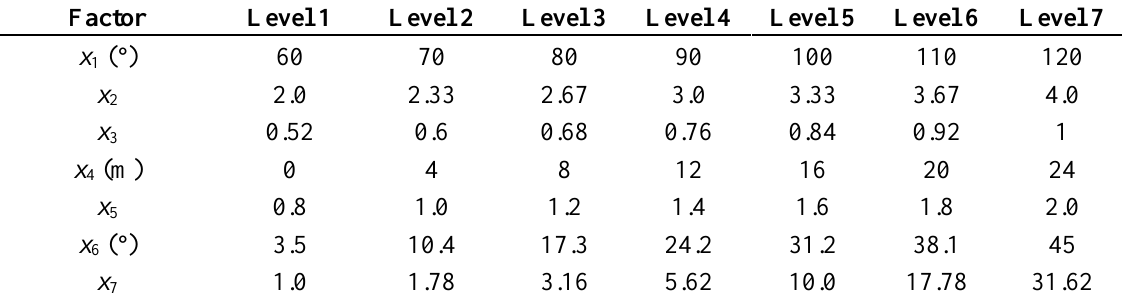
Table 1. Selection of factors in numerical orthogonal